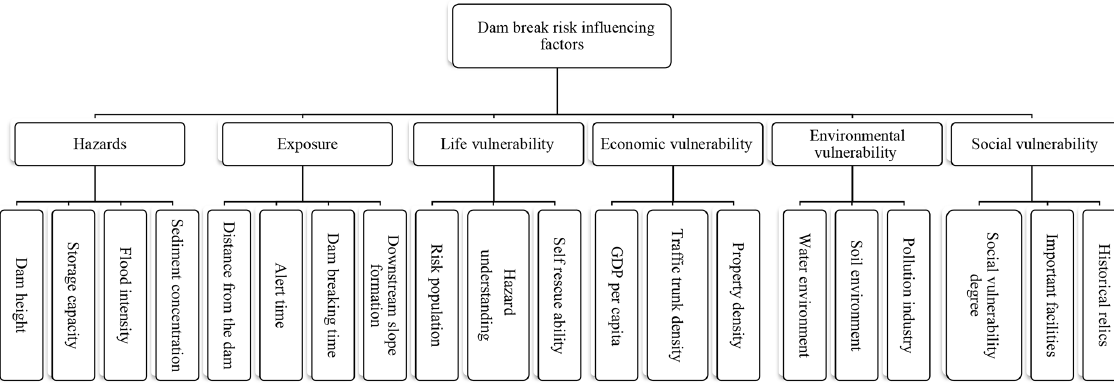
Figure 1. Index of influencing factors of dam break risk